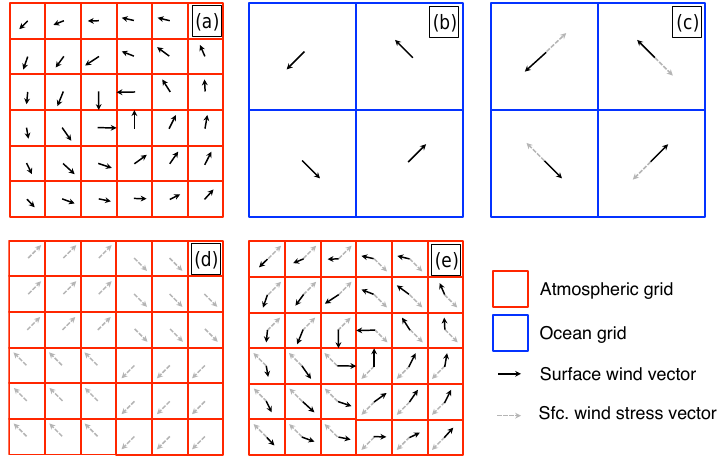
Figure 1. Coupling procedure in CESM. Red (blue) boxes indicate atmospheric (ocean) grid cells. Black (gray) solid (dashed) vectors show surface wind (wind stress) vectors. Surface winds are taken from the atmospheric grid (a) and mapped to the ocean grid (b) . Calculations of surface drag are carried out on the ocean grid (c) with surface wind stress vectors being remapped back to the atmosphere grid (d) for use in atmospheric integration at the next time step (e) . Surface heat fluxes are calculated in a similar manner.